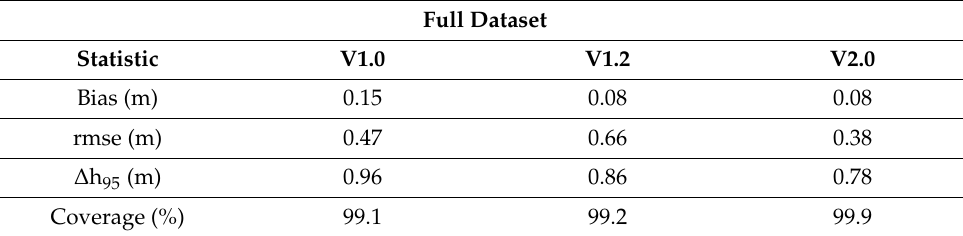
Table 2. Means for Kalman-filtered bathymetries of the four basic performance statistics (rows) comparing across the three versions of the cBathy algorithm (columns). Statistics are computed for the full dataset of 39 surveys, comparing the mid-afternoon Kalman bathymetry for each survey date to ground truth.